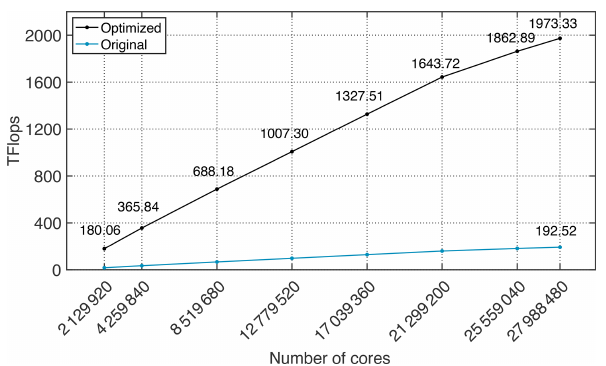
Figure 14. The peak performance results for simulations with 1km resolution. Numbers along the graph line are the peak performances for simulations with different cores. The peak performance with 27988480 cores reaches 1.973 PFLOPS.